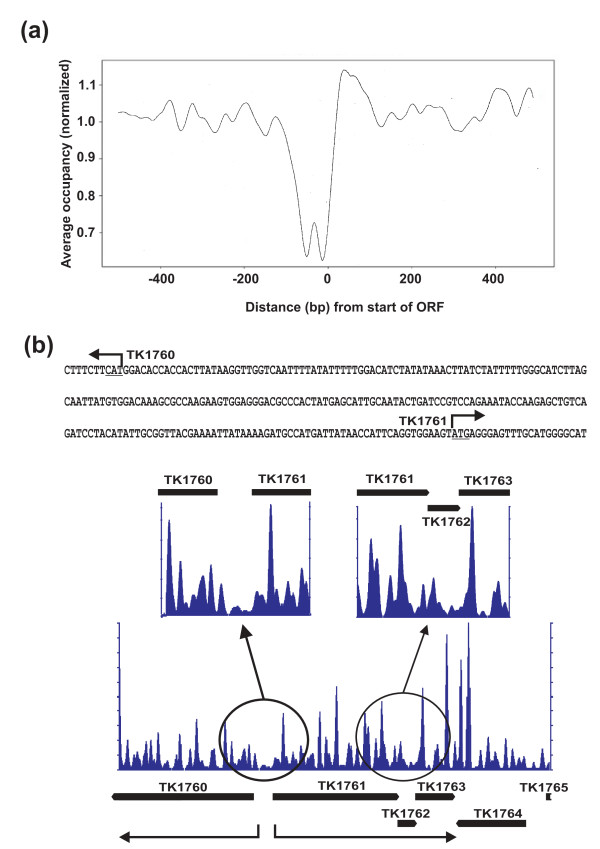
Depletion of archaeal nucleosomes in intergenic regions. (a). The occurrence of nucleosomes relative to the start codons of all open reading frames (ORFs), as documented in the Archaeal Genome Browser [39]. The frequency of occurrence of each nucleosome read is plotted relative to the average value of occurrence of all nucleosomal reads sequenced from the T. kodakarensis TS517 genome. (b) The sequence of the intergenic region separating TK1760 and TK1761 is positioned above the profiles of nucleosomes assembled in vivo at this locus and downstream, within the well-established TK1761-TK1762-TK1763 operon [40].